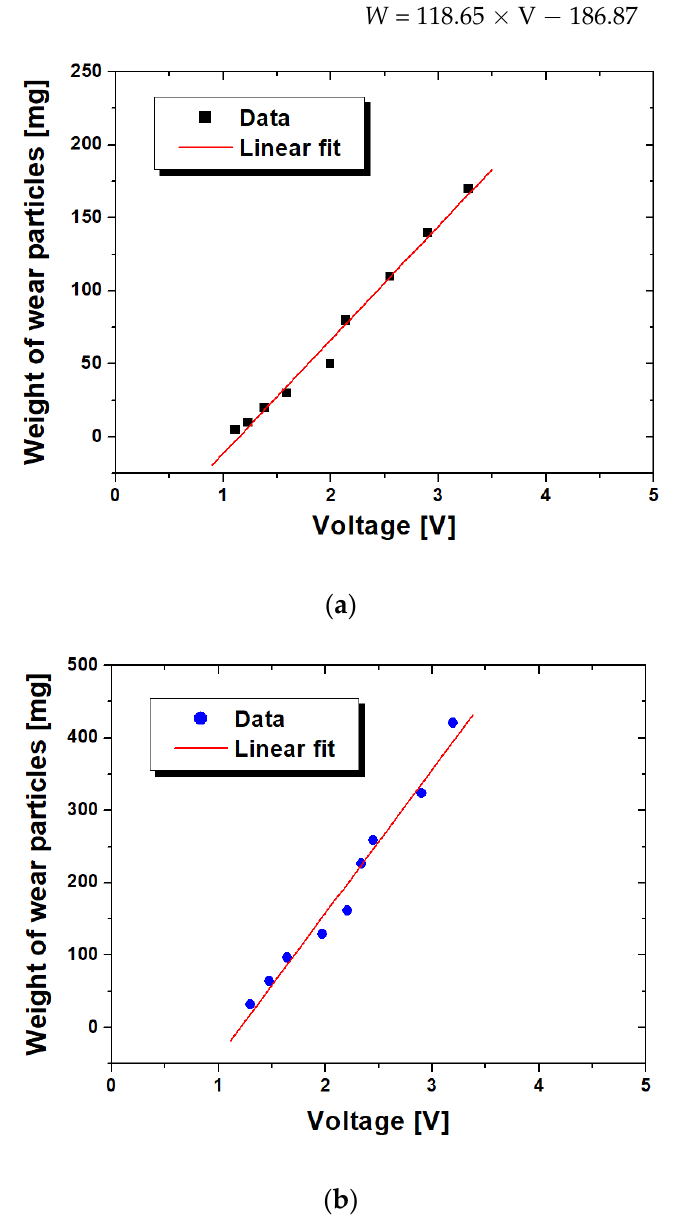
Figure 7. Linear regressions of wear amount against voltage: ( a ) Fine particles; ( b ) Coarse particles.